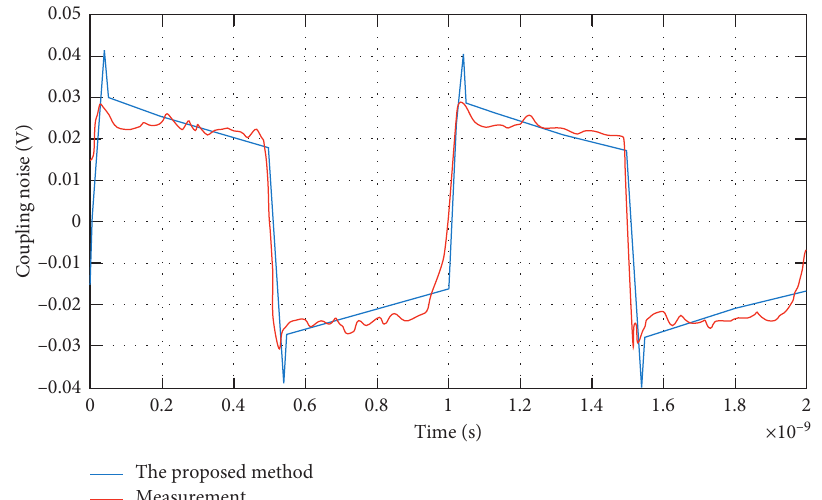
Figure 17: The proposed method and measured coupling noise of TSV-contact in the time domain (the input clock frequency at port 1 is 1